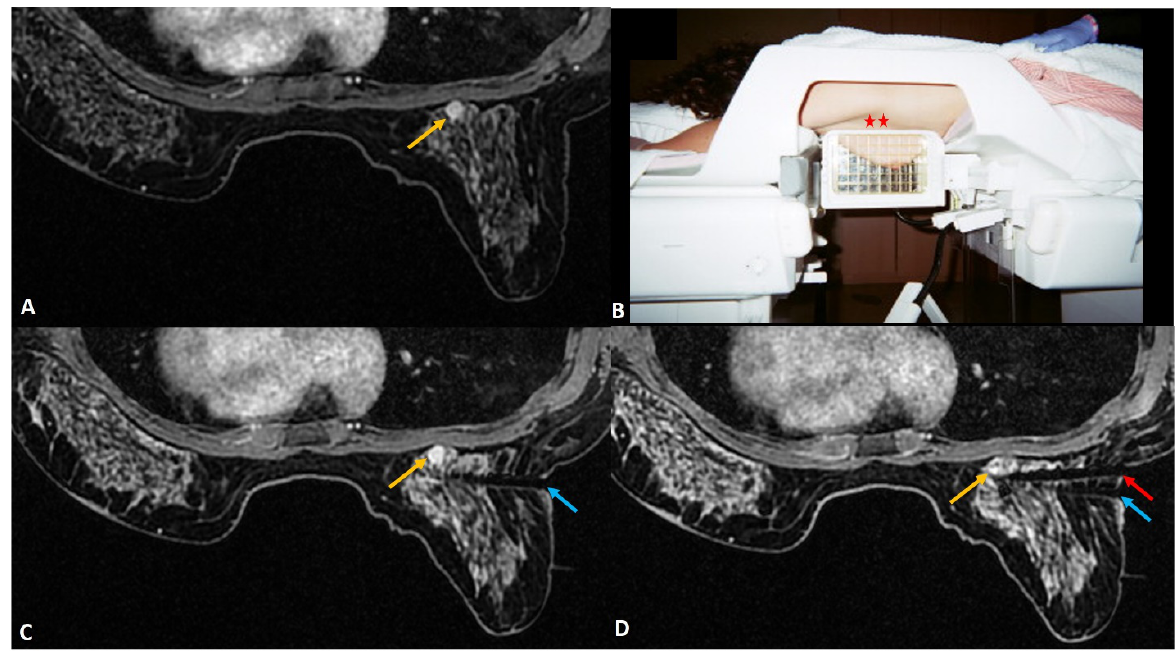
Figure 4. ( A ). In a woman with newly diagnosed left breast cancer, staging MRI identified a 6 mm indeterminate enhancing mass (yellow arrow) in the right breast located posteriorly close to chest wall. ( B ). During biopsy small dead space (red asterisks) is always noted close to the chest wall that lies beyond the grid. ( C ). For biopsy, the introducer was inserted through the posterior most hole in the grid (blue arrow) close to the lesion (yellow arrow). The needle failed to reach the target adequately. A second introducer guide was inserted outside the grid (in the area of red asterisks), close to the chest wall using free-hand direct puncture. ( D ). The posterior needle (red arrow) was seen to adequately reach the target and biopsy was completed successfully. The histology was reported as lobular neoplasia.